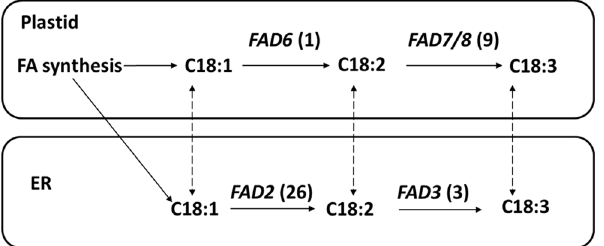
Fig 6. Artemisia sphaerocephala fad genes involved in the unsaturated fatty acid synthesis pathway. Note: The numbers in the brackets indicate gene numbers.